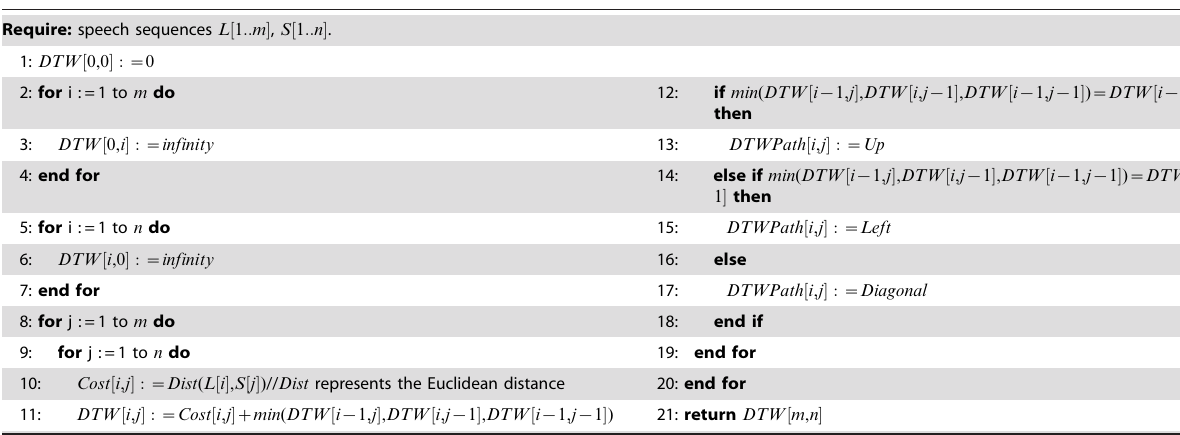
Table 1. Algorithm 1: Dynamic Time